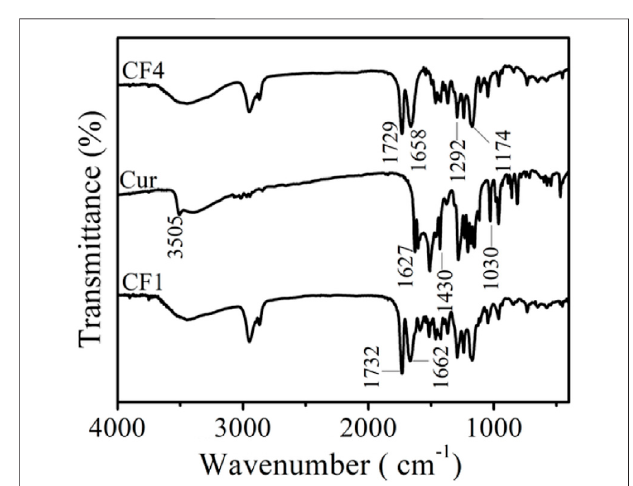
FIGURE 2 | FTIR spectra of CF4, Cur, and